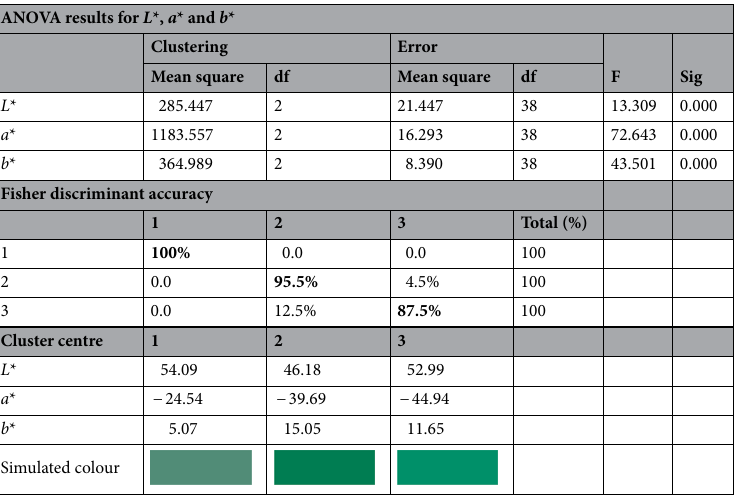
Table 1. ANOVA results, Cluster centre and Fisher discriminant accuracy. Bold words indicate the accuracy of the prediction.